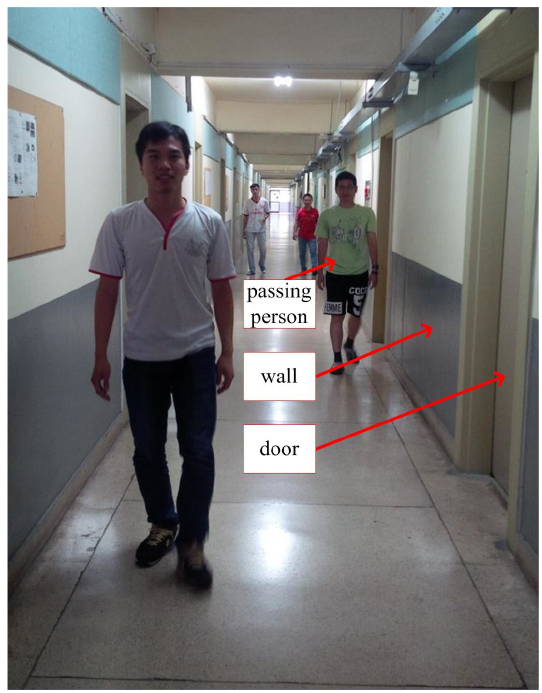
Figure 7. Corridor with doors and passing persons.